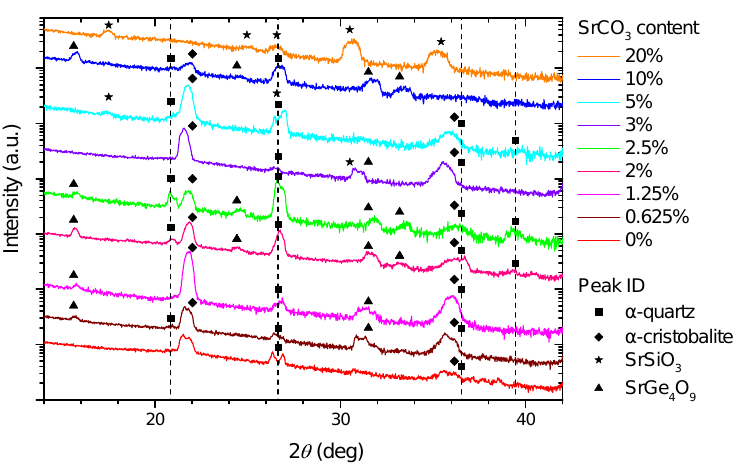
Figure 5. GIXRD scans of the annealed sample series, in the 2 θ range of 14–42 ◦ . The vertical lines denote the position of diffraction peaks from the α -quartz structure [33]. The full scan (10–80 ◦ ) is shown in Figure